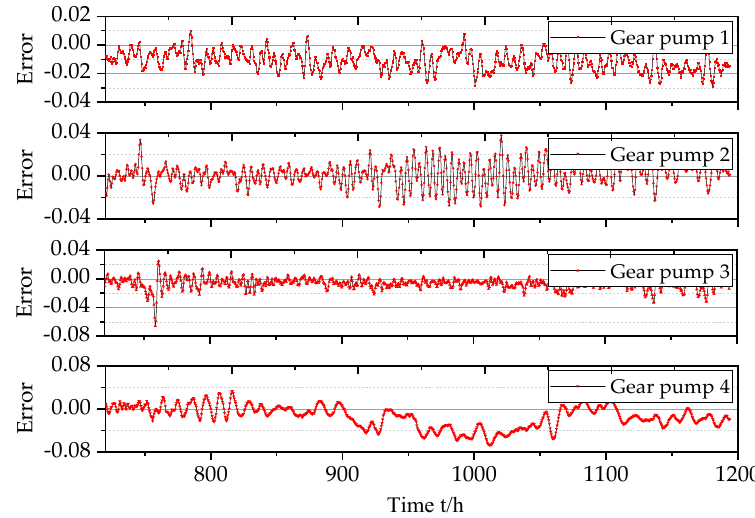
Figure 14. Prediction deviation curve.